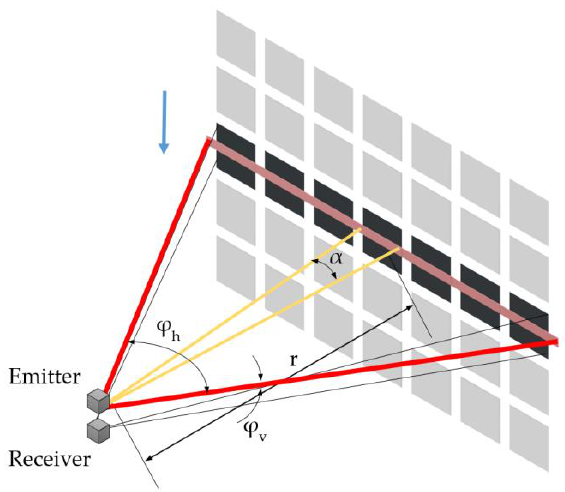
Figure A3. Horizontal blade irradiation.